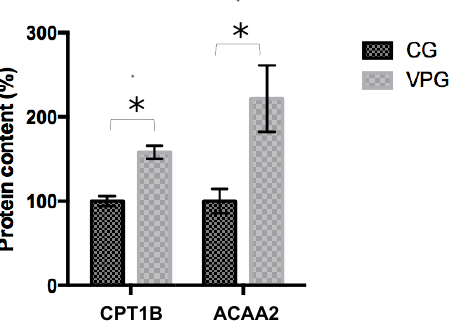
Figure 2. ( A ) Western blotting analysis of selected differentially expressed proteins in skeletal muscle from the VPG vs. CG. ( B ) Densitometric analysis of CPT1B and ACAA2. Values were normalized against GAPDH. The results, expressed as percentages, are shown as means ± SD. * p < 0.05.